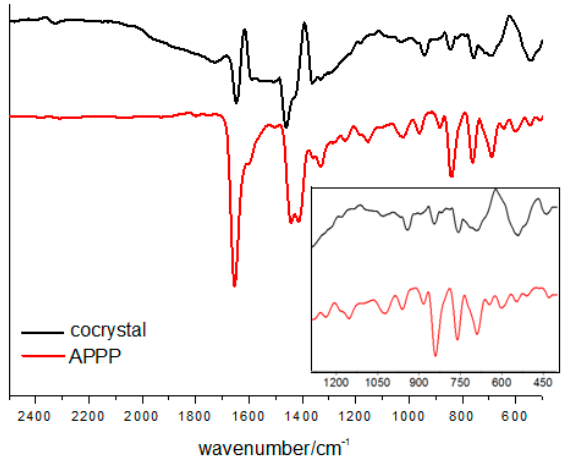
Figure 5. FT-IR spectra of the cocrystal and pure APPP.